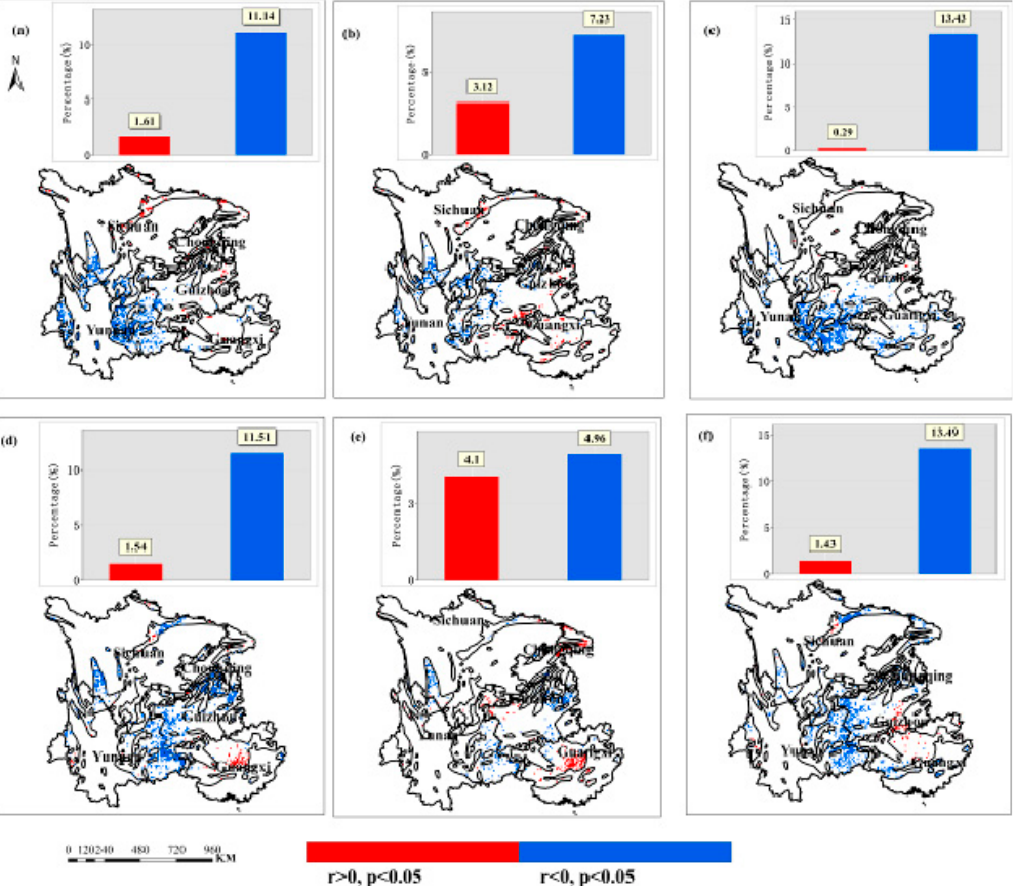
Figure 7. Significant correlation between climate changes and the NDVI at the 2.5-year time scale in the karst region of southwest China: ( a ) correlation between temperature and NDVI from 1982–2015, ( b ) before the breakpoint; ( c ) after the breakpoint; ( d ) significant correlation between precipitation and NDVI from 1982–2015, ( e ) before the breakpoint, ( f ) after the breakpoint; (r: correlation coefficient; p: significance level). The insets show the frequency distribution of the corresponding values.